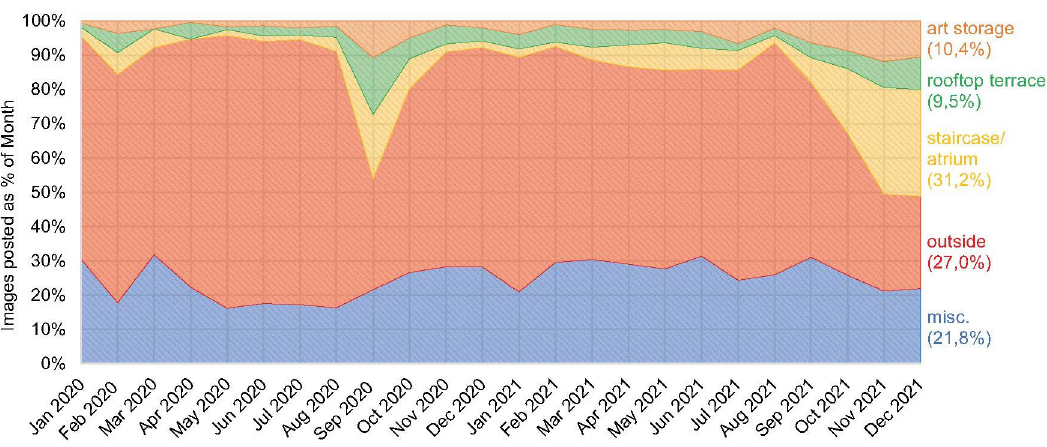
Fig 11. Photograph frequency by point of interest (by